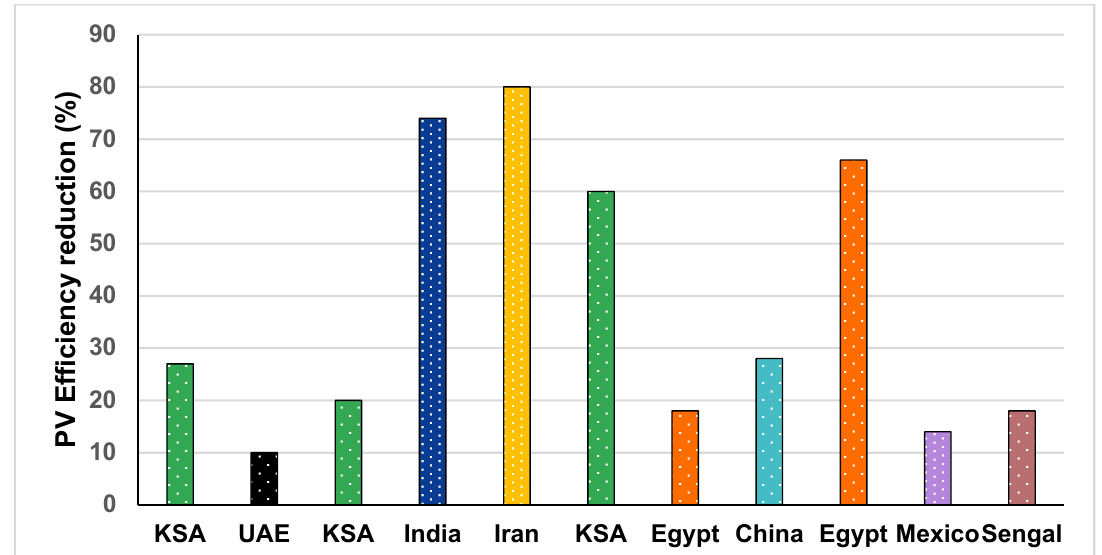
Figure 18. The monthly reduction in PV module efficiency due to the dust accumulation [58].